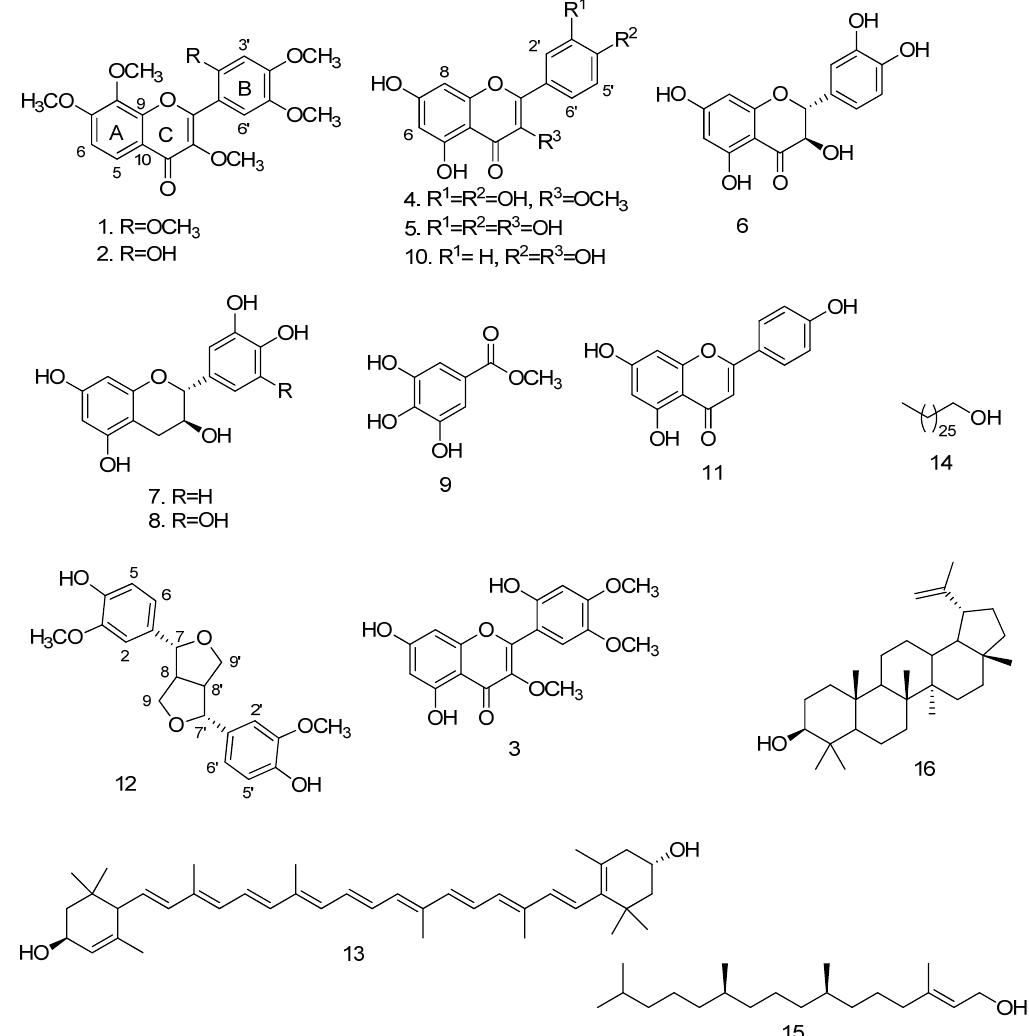
Figure 1. Structures of the compounds isolated from V . xanthophloea .